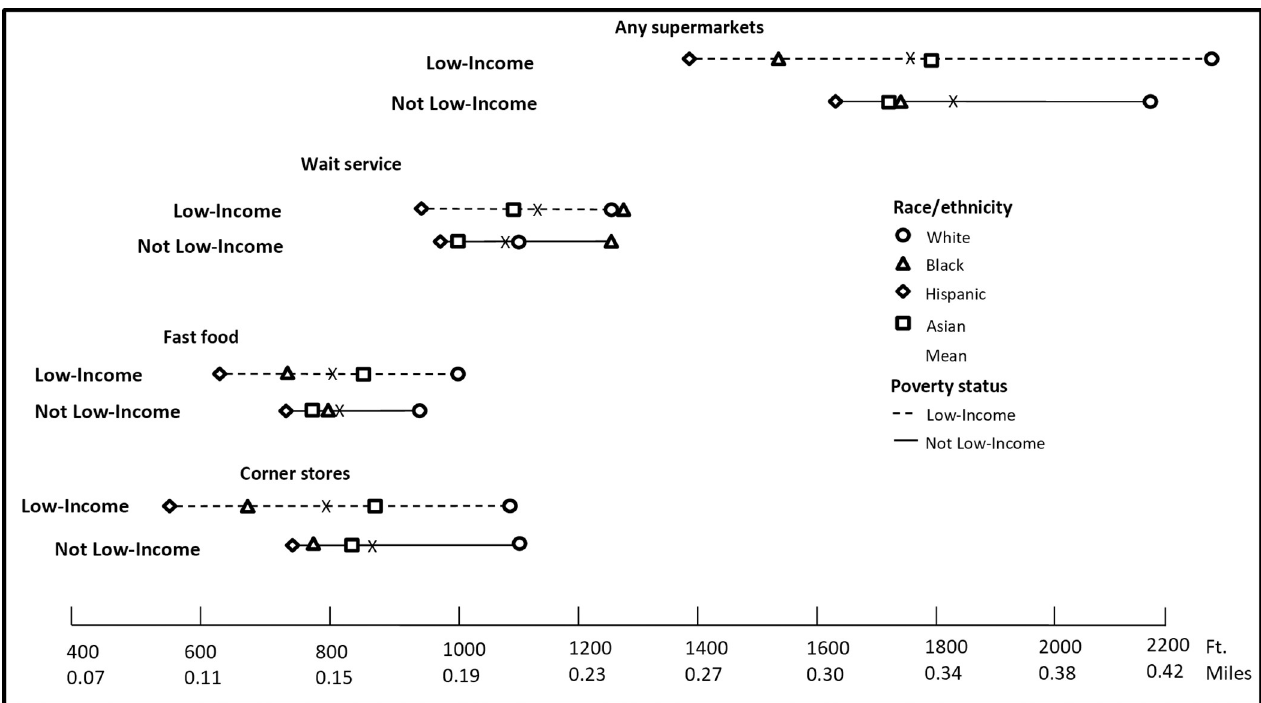
Fig 3. Mean nearest distance in feet to food facilities from school by race and poverty interactions in 2013. We conducted joint F-test with school level clustered errors suggests significant differences among income and race groups (p < 0.05). And pair-wise T-tests for multiple comparisons based on Bonferroni correction (28 pairs in total, with each pair tested on all four food outlets, separately). More often than not, the T-test indicated no statistically significant difference. S19 Table presents test results (p-values) for each pair.